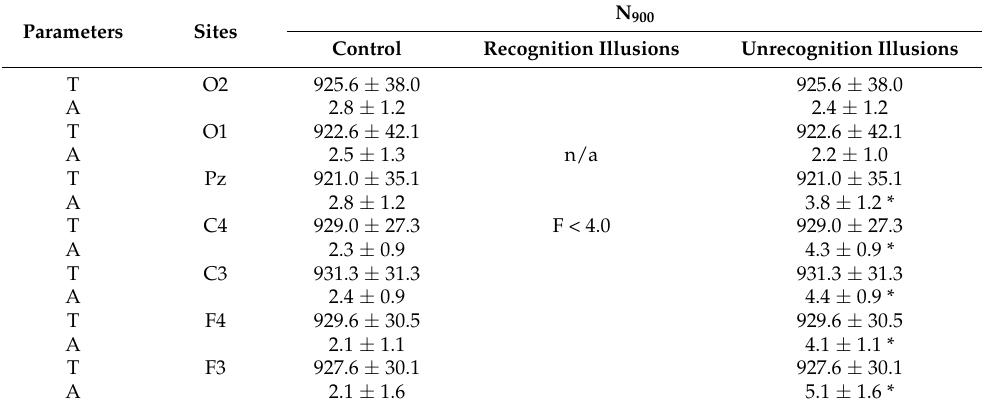
Table 6. Amplitude (A, uV) and time (T, ms) characteristics of the component N 900